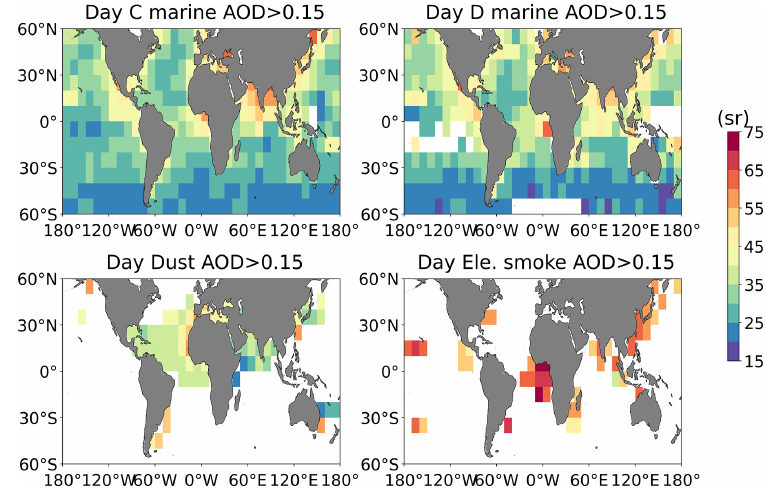
Figure A3. Daytime median CALIOP–SODA lidar ratios of data associated with AOD greater than 0.15 within 10 ◦ × 10 ◦ grids for four tropospheric aerosol types that contain sufficient number of